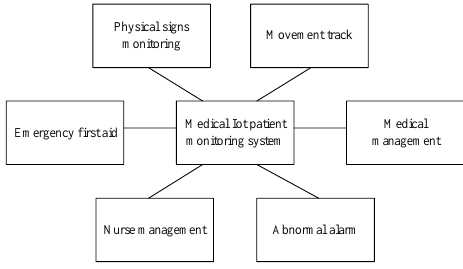
Figure 2. Variety of healthcare